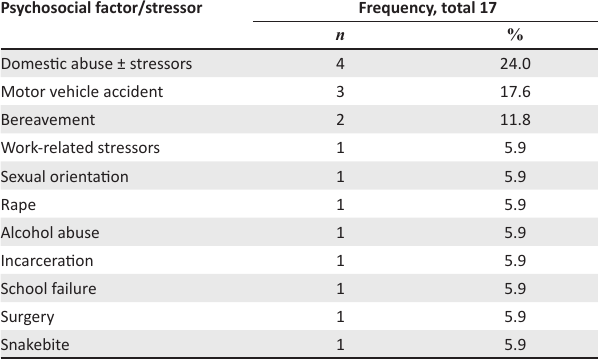
TABLE 8: Psychosocial factors.